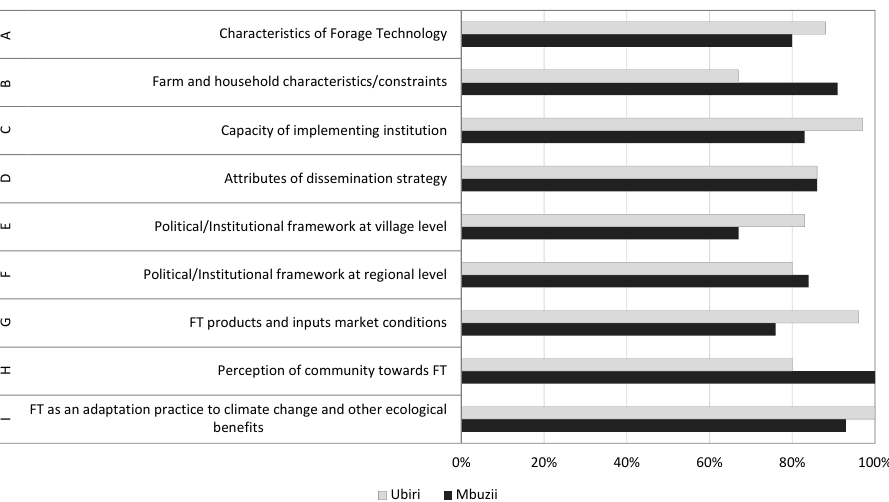
Figure 4. Thematic influence on adoption potential for the two villages in the case study region: Mbuzii ‐ Bumbuli and Ubiri ‐ Lushoto.